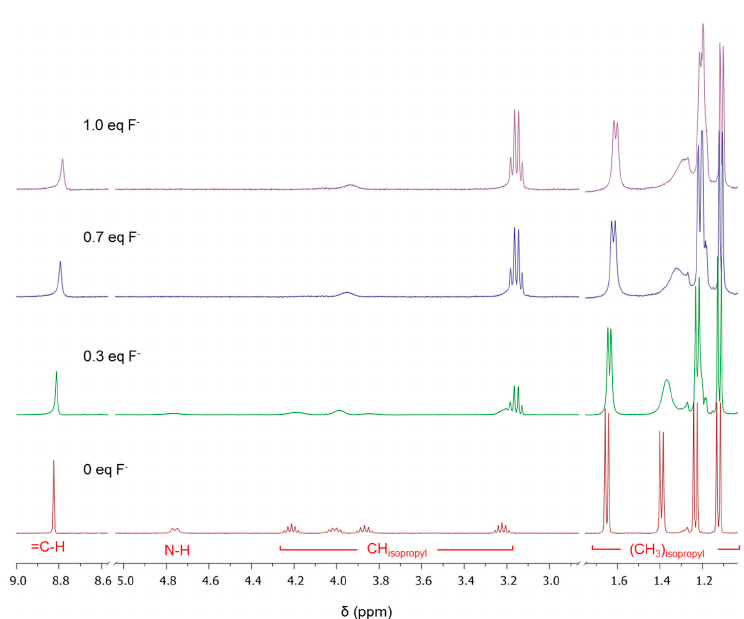
Figure 7. 1 H-NMR (360 MHz, CD 3 CN) spectra of ZW1 in solution upon the addition of 0, 0.3, 0.7, and 1.0 equivalents of fluoride anions. The increasing signals at δ ~3.2 and 1.2 ppm correspond to the ethyl and methyl protons of the tetraethylammonium counter-cations added. The same effects were observed for ZW3 solutions. Figure 8. ( a ) Fluorescence response of ZW1 in acetonitrile upon the addition of different anions. Spectrophotometric fluorescent titrations of ZW1 in acetonitrile with a solution of tetraethylammonium ( b ) Fluoride (10 mM) and ( c ) Cyanide (10 mM) in acetonitrile. The arrows indicate the evolution of